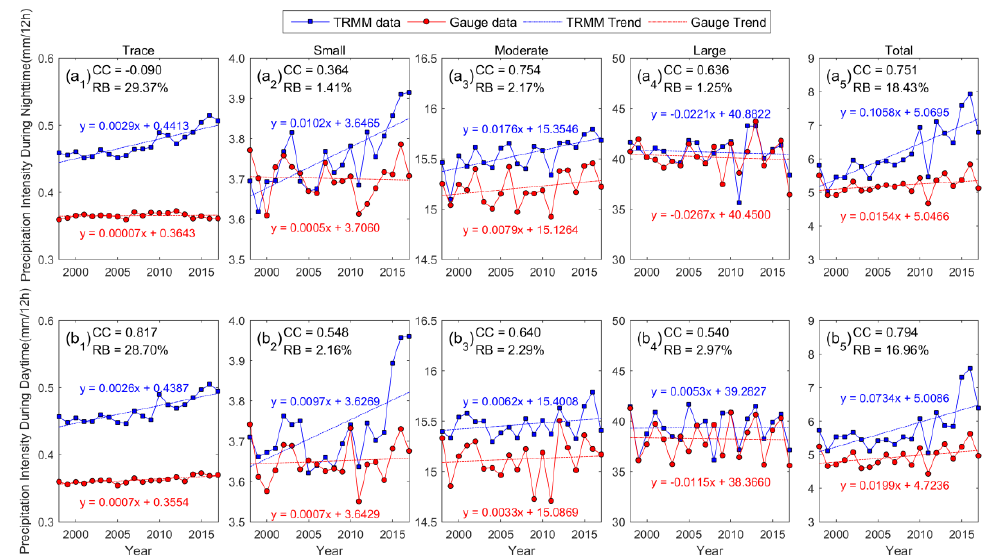
Figure 3. As in Figure 2, but for the intensity of precipitation. The y -axis scales are different for different precipitation categories.